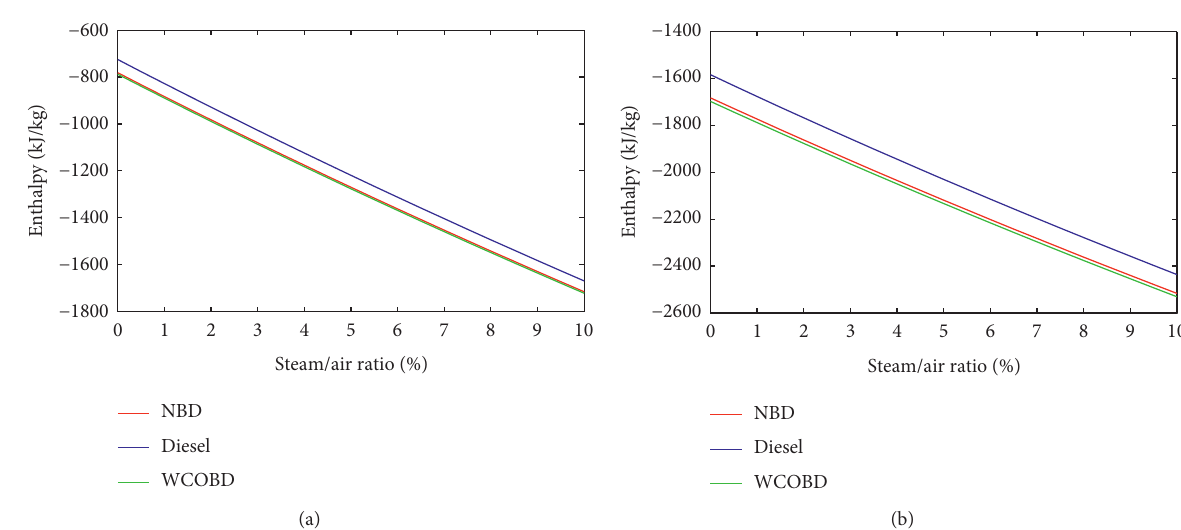
Figure 12: Variation of gas mixture enthalpy with steam injection